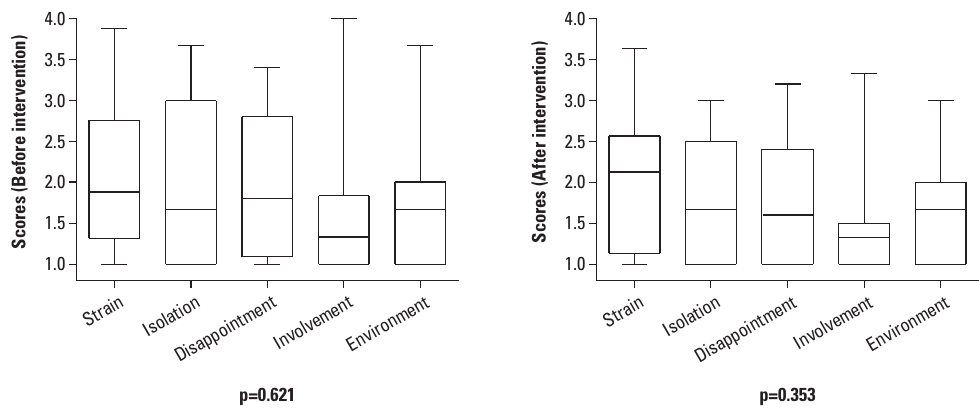
Figure 2. Tendencies in distribution of caregiver scores by domain and time on Caregiver Burden Scale. Results of Kruskall-Wallis tests among domains, pre- and postintervention, shown under each box blot.